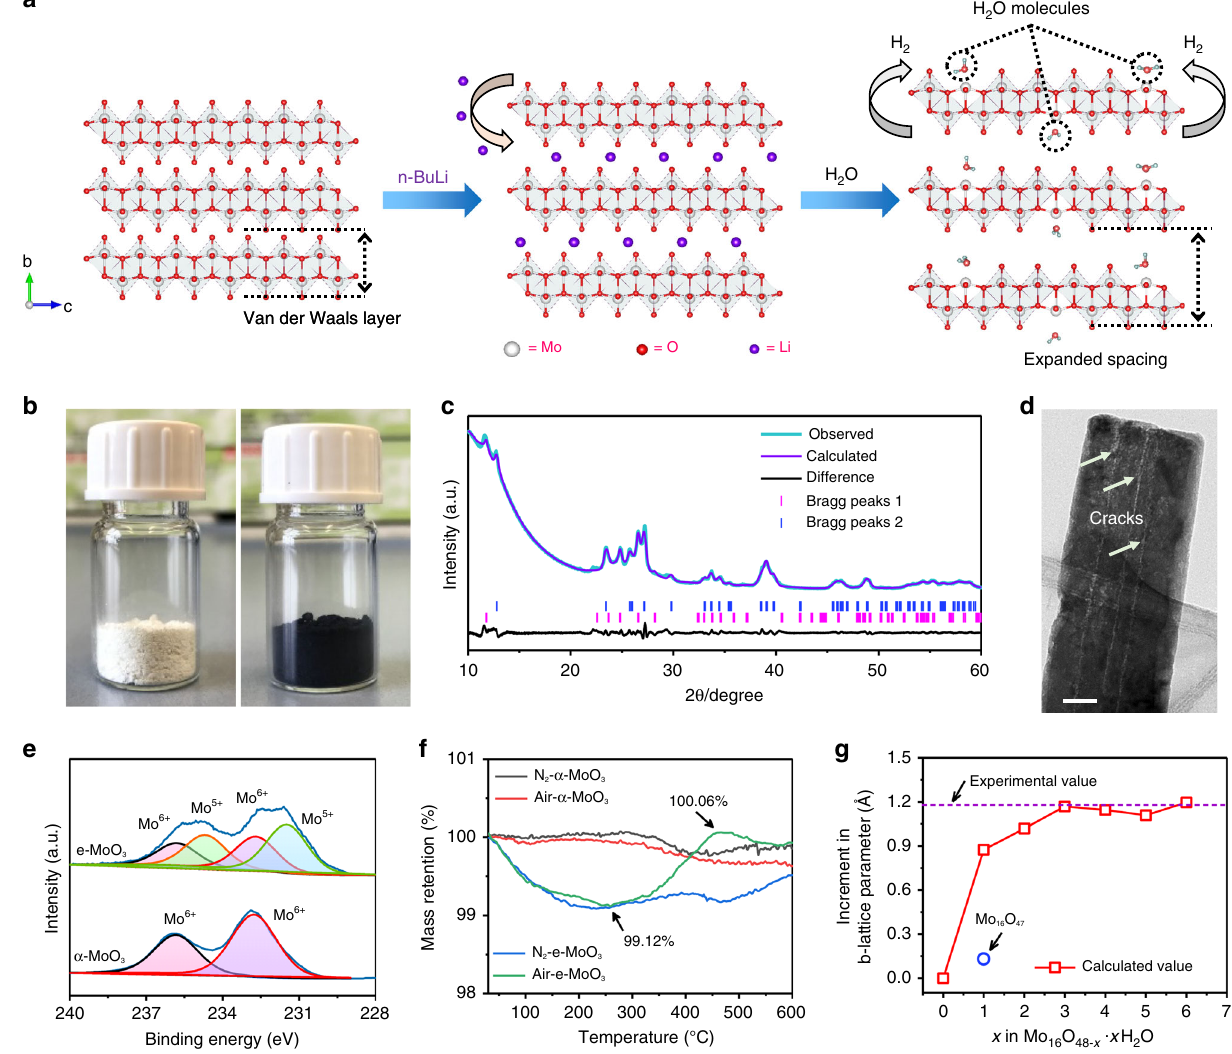
Fig. 1 Structure and composition analysis of α -MoO 3 and e-MoO 3 . a Schematic representation of expansion process from pristine α -MoO 3 (left), reaction with n -butyllithium (middle), to e-MoO 3 with H 2 O molecules located at the oxygen-defect sites (right). White: Mo; Red: O; Purple: Li; Blue: H. b Digital photos of α -MoO 3 (left) and e-MoO 3 (right). c Rietveld re fi nement of XRD pattern and d high-resolution TEM image for e-MoO 3 .Scale bar in d 50 nm. e Mo 3d XPS pro fi les of α -MoO 3 and e-MoO 3 . f TGA curves of α -MoO 3 and e-MoO 3 measured in nitrogen and air atmosphere. g Calculated increment in b - lattice parameter induced by H 2 O intercalation. The value is also compared with the calculated value of oxygen-defective MoO 3 − x (Mo 16 O 47 ) and experimental